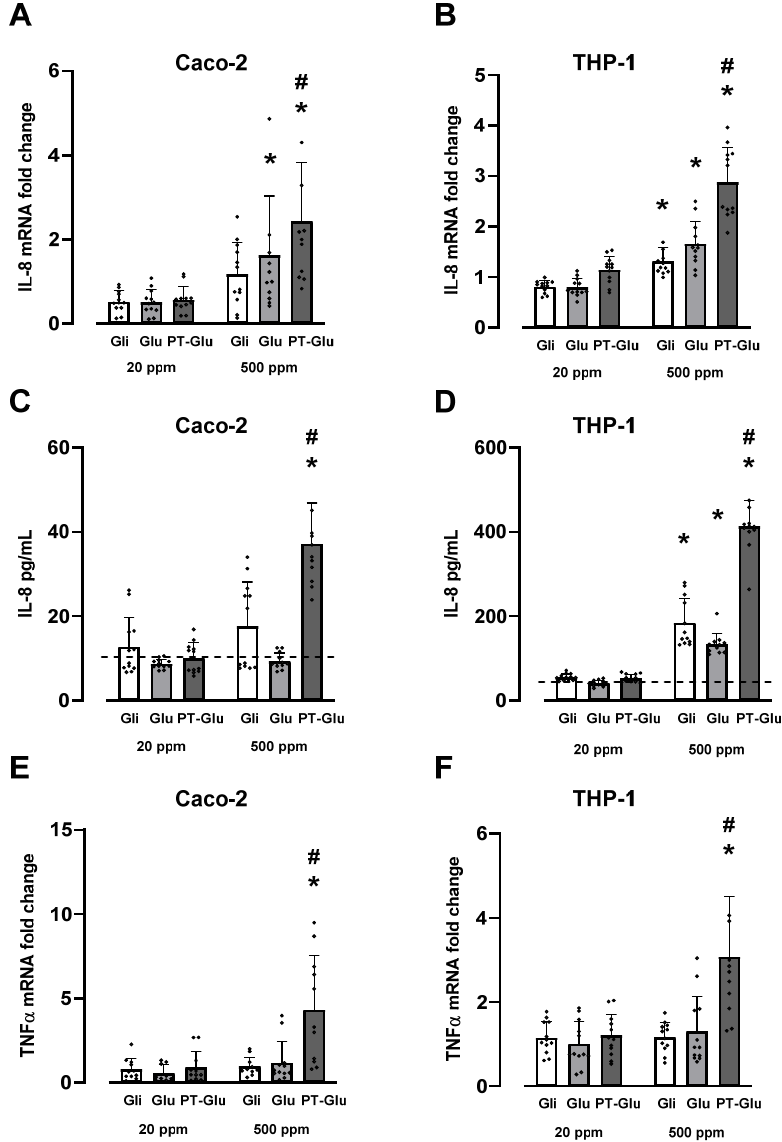
Figure 1. Differential effects of 20 ppm (20 mg/L) and 500 ppm (500 mg/L) of crude gliadin (Gli), crude gluten (Glu) or PT digested gluten (PT-Glu) on IL-8 gene expression ( A , B ), IL-8 protein secretion ( C , D ) and TNF- α gene expression ( E , F ) in Caco-2 and THP-1 cells, respectively. The dashed line represents effects of control media only for IL-8 protein expression. * represents significant difference as compared with the 20 ppm comparator group, p < 0.05. # represents significant difference as compared with other 500 ppm treatment groups, p < 0.05.